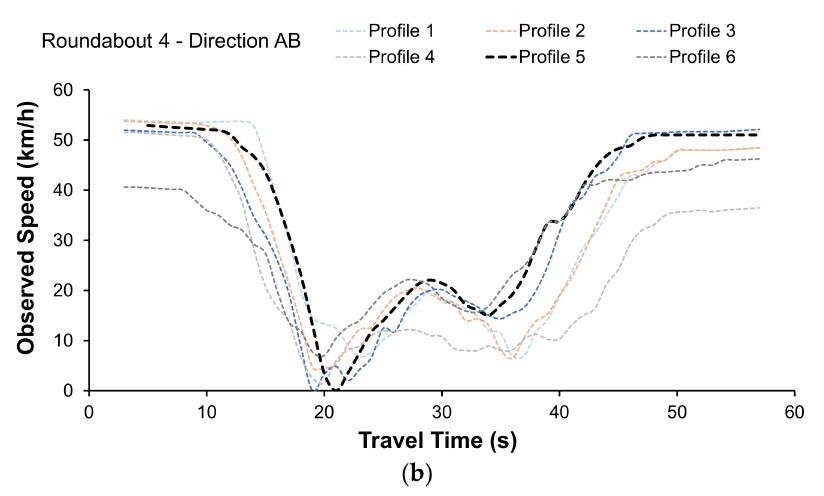
Figure 3. Second-by-second speed-time profiles of through movement observed in direction AB: ( a ) profile without stopping at Roundabout 2 in Figure 2b; ( b ) profile with one stop at Roundabout 4 in Figure